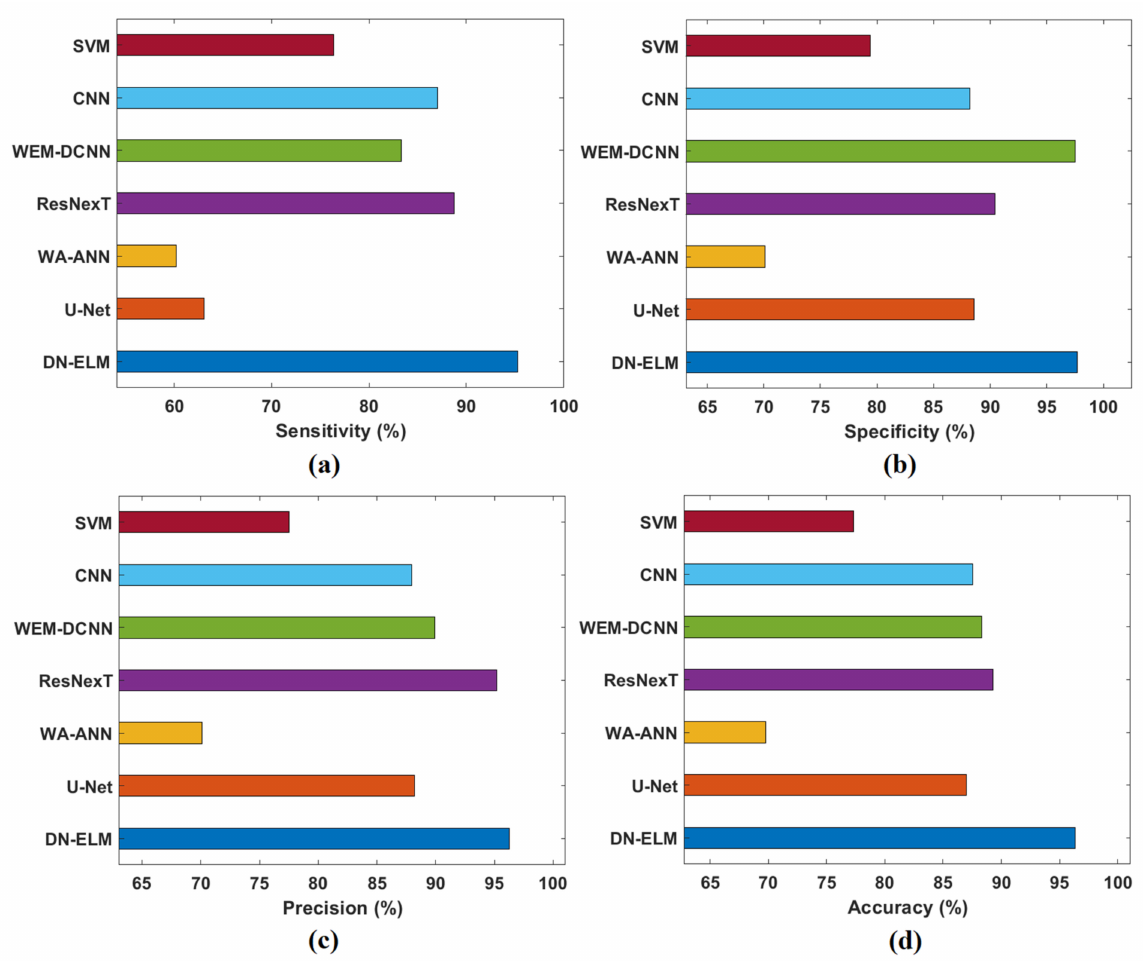
Figure 7. Comparative results analysis of DN-ELM with existing models: ( a ) sensitivity, ( b ) specificity, ( c ) precision, and ( d )